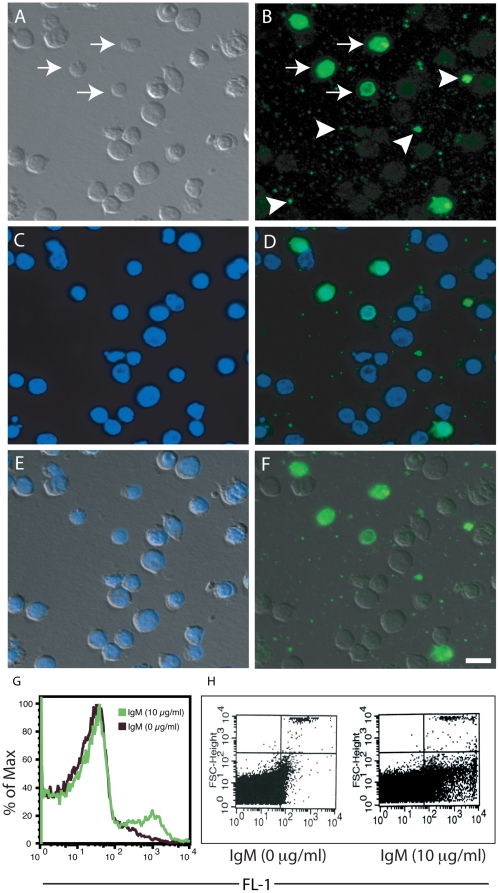
Human IgM preferentially binds to a subpopulation of late apoptotic cells and vesicle-like small apoptotic particles (v-SAPs) or apoptotic “microparticles”.(A) Differential interference contrast (DIC) microscopy image. (B) Epifluorescence microscopy image showing the preferential interaction between IgM (green) and small apoptotic cells (arrow) and microparticles (arrowheads). (C) Fluorescence image showing that these cells still contain DNA stained blue with DAPI. (D) Overlay of (B) and (C) shows the locations of IgM binding in relation to the location of the nuclei. (E) Overlay of (A) and (C) shows the locations of nuclei in these cells. (F) Overlay of (A) and (B) shows IgM also binds to larger cells as small faint punctate dots. Overall, these images show that IgM avidly binds to a subpopulation of relatively smaller cells with smooth regular surfaces (arrows) and v-SAPs or microparticles (arrowheads). Scale bar is 10 µm. (G–H) Flow cytometry showing that IgM binds small size late apoptotic cells and microparticles or v-SAPs. (G) Flow cytometry shows that large amounts of IgM can bind to smaller apoptotic cells using a voltage setting that is sensitive to events measured at 2 µm or greater. (H) Flow cytometry confirming that IgM can bind to v-SAPs using a voltage setting that is sensitive to events measured at 0.5 µm or greater.